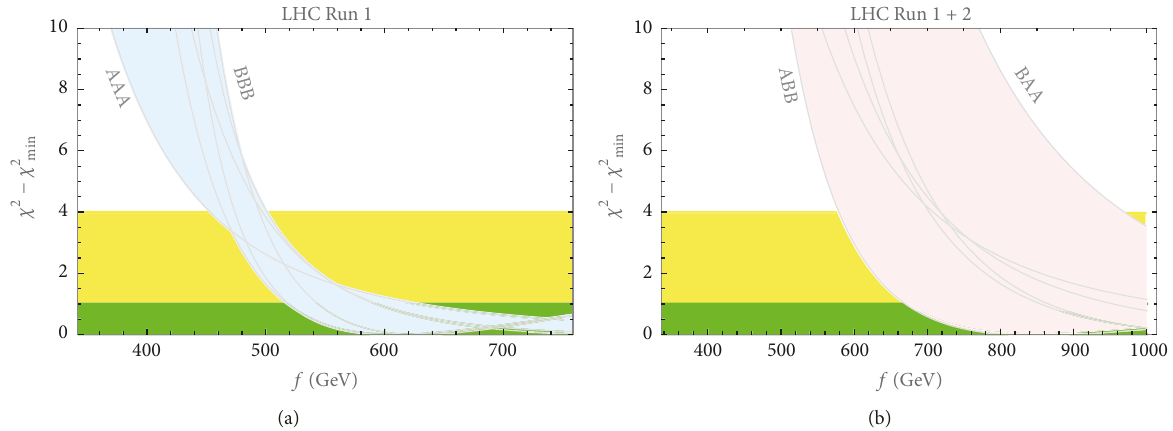
Figure 1: 𝜒(𝑓) 2 − 𝜒 2 for Run 1 (a) and combination of Runs 1 and 2 (b) datasets. The lines correspond to different choices of fermion min couplings 𝜅 퐴,퐵 퐹 for (𝜅 푡 , 𝜅 푏 ,𝜅 휏 ) . For example, AAA indicates 𝜅 푡 = 𝜅 푏 = 𝜅 휏 = 𝜅 퐴 퐹 .